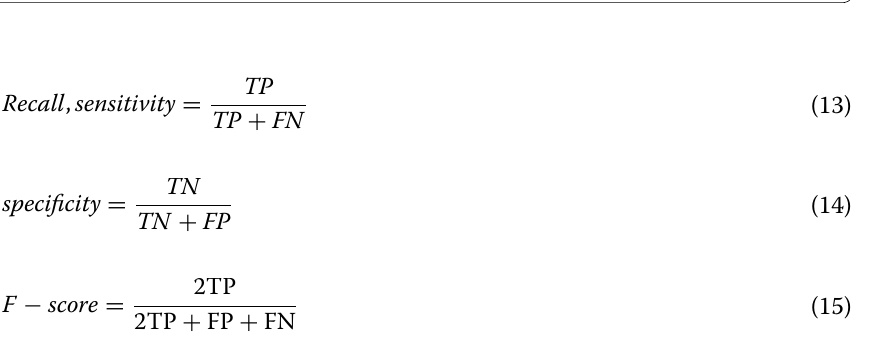
Fig. 5 F-score of the Alzheimer’s disease data set using a non-whitening method, a method with aggregate features and the proposed